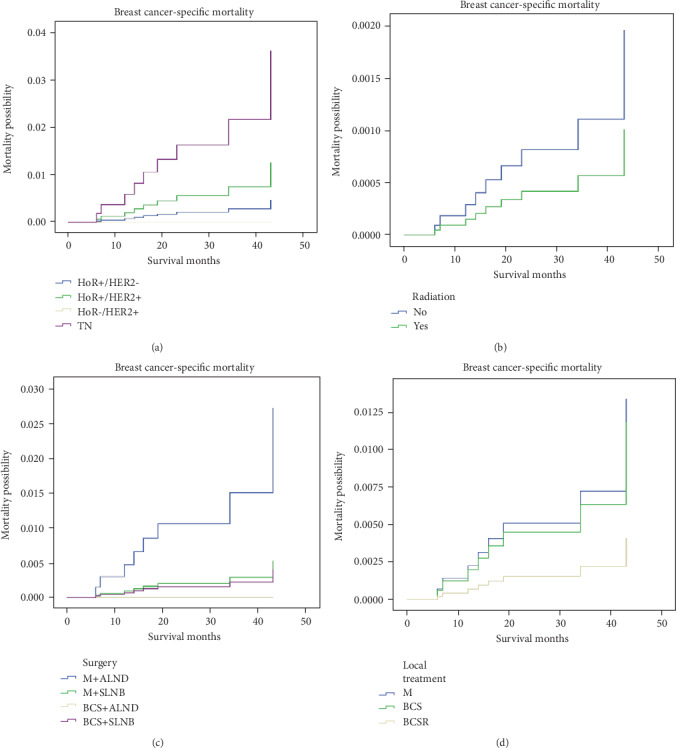
Weighted Kaplan-Meier curves of breast cancer-specific mortality (BCSM) in subgroup analysis. (a) BCSM is based on breast subtype. (b) BCSM is based on radiotherapy. (c) BCSM is based on surgery. (d) BCSM is based on local treatment.